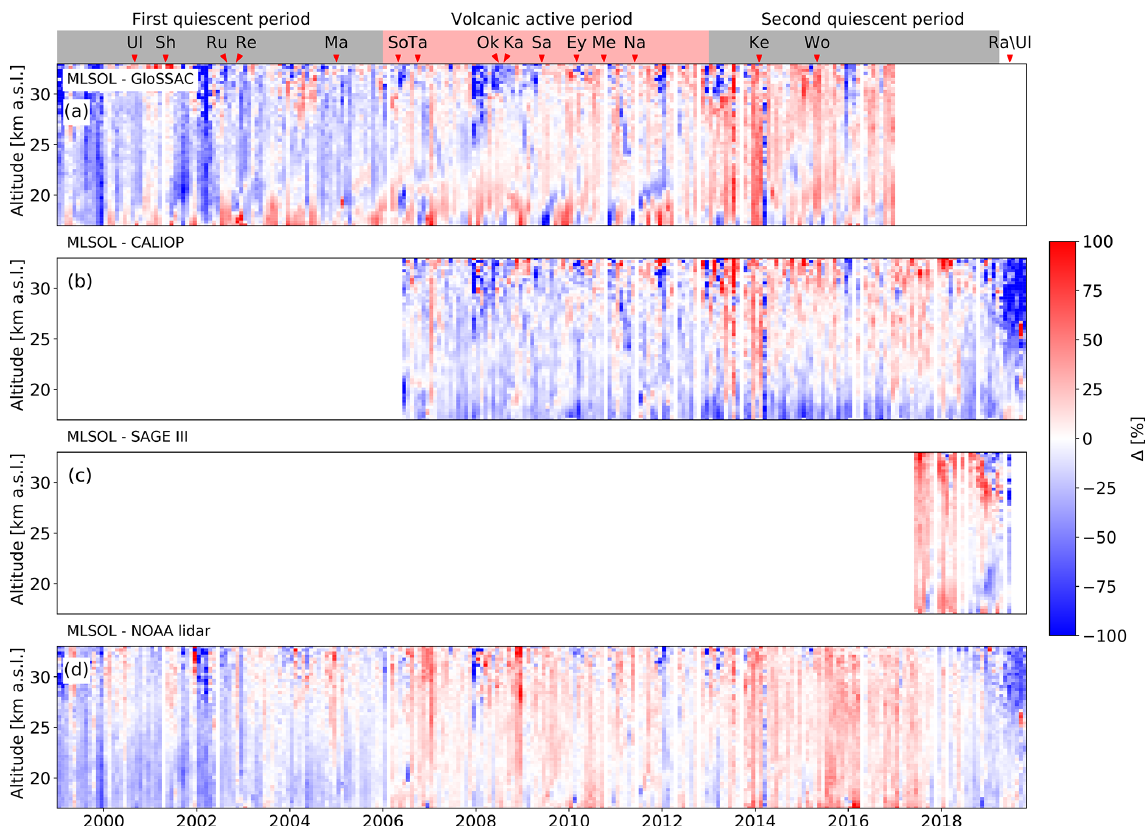
Figure 12. Mean relative difference between MLSOL and GloSSAC (a) , CALIOP (b) , SAGE III (c) , and NOAA lidar (d) . The mean relative difference between MLSOL and each other dataset ( X ) is calculated as ( MLSOL − X)/